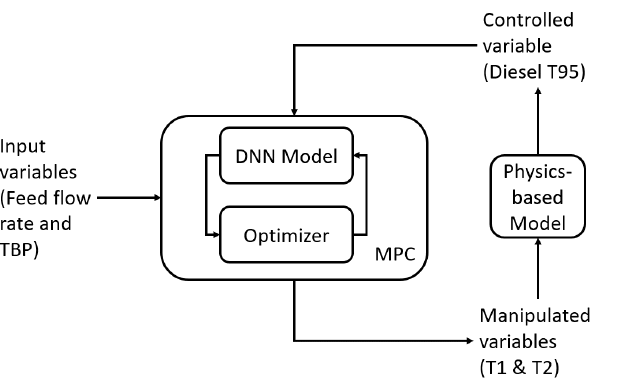
Figure 4. FFMPC structure with a data-driven model for optimization and a physics-based model to simulate the plant